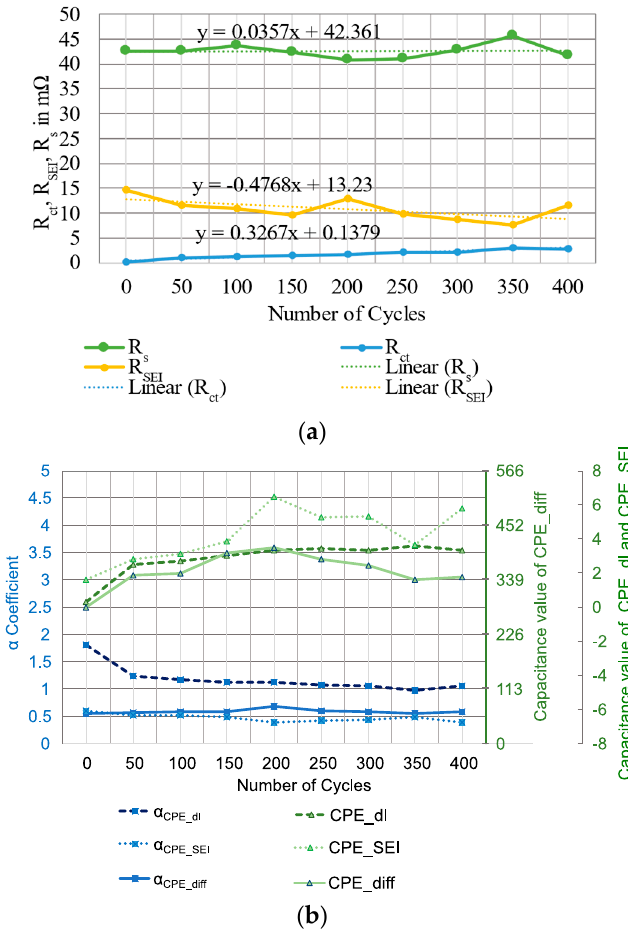
Figure 10. ( a ) Analysis results of R s , R ct , and R SEI for cell one as a function of the number of cycles, ( b ) Analysis results of parameters of Q dl Q SEI and Q diff for cell one as a function of the number of cycles.